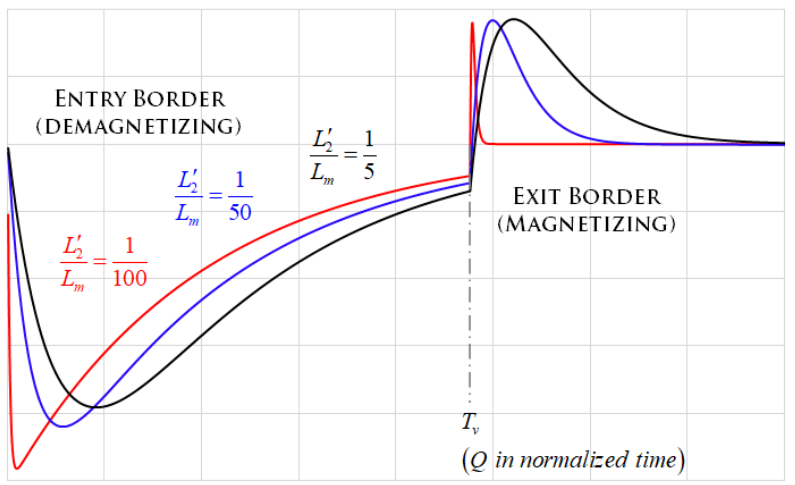
Figure 4. Secondary mmf waves compared, as secondary leakage reactance increases.